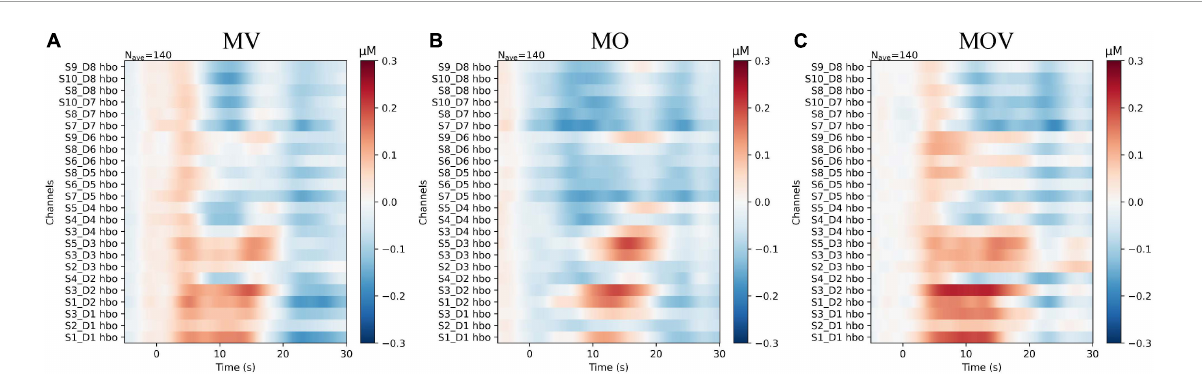
FIGURE6 The subplots (A–C) correspond to the change in HbO content of each channel under the three rehabilitation tasks of MV, MO, and MOV, respectively. The horizontal axis of the subplot indicates the task time, with the task start time being 0 s and the task duration being 10 s. The vertical axis of the subplot indicates the distribution of channels, with the 12 left and right fNIRS channels in the upper and lower parts, respectively. The colors of the images correspond to the values of HbO, which ranged from − 0.3 to 0.3 µ Mol/L.